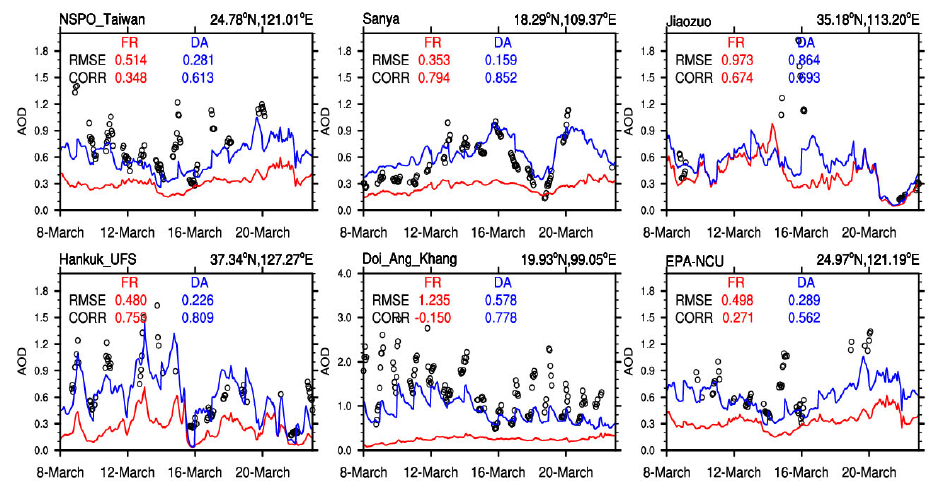
Figure 6. Time series of the observed and simulated hourly AOD for the FR and DA experiments in six typical stations from 8 to 22 March 2021.